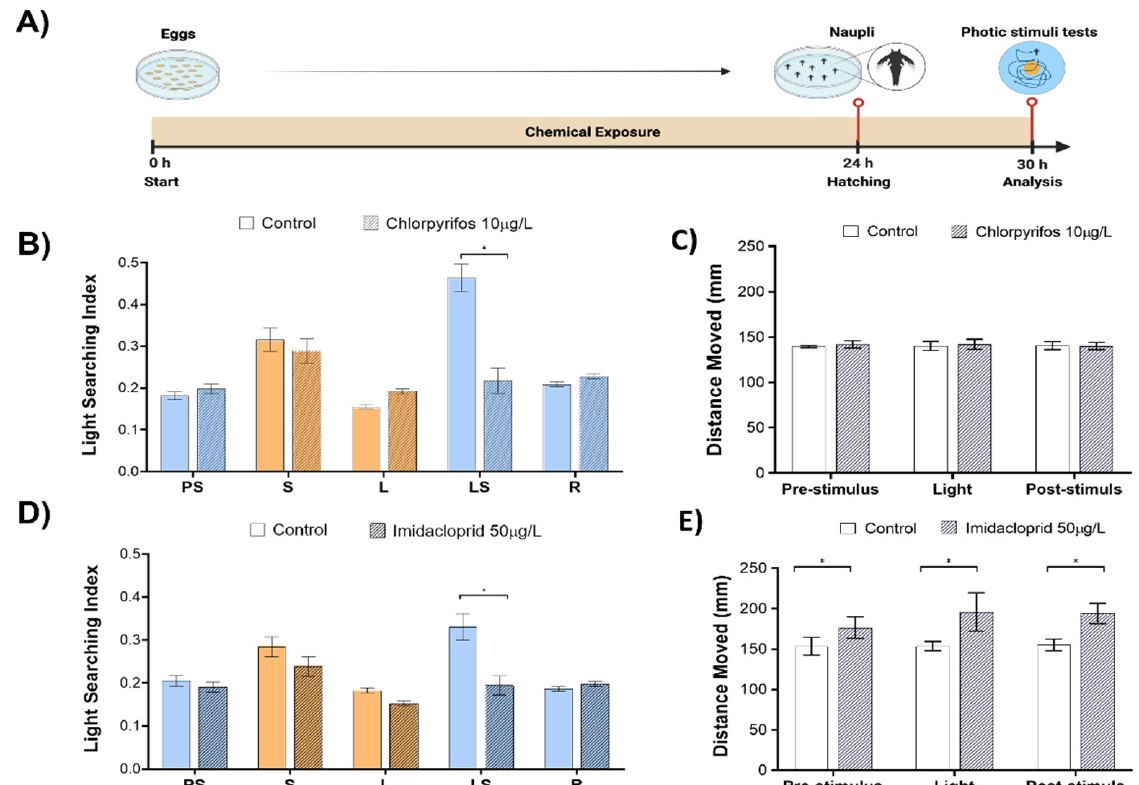
Figure 2. Phototactic responses of larval brine shrimp exposed to sub-lethal concentrations of insecti- cides. ( A ) experiment workflow depicting the phototactic test protocol; ( B ) phototactic fingerprints upon exposure to organophosphate chlorpyrifos (10 µ g/L); ( C ) animal overall motility (total distance moved in mm) analyzed in each phase of light OFF-ON-OFF cycle upon exposure to chlorpyrifos (10 µ g/L); ( D ) phototactic fingerprints upon exposure to neonicotinoid imidacloprid (50 µ g/L); ( E ) animal overall motility (total distance moved in mm) analyzed in each phase of light OFF-ON- OFF cycle upon exposure to imidacloprid (50 µ g/L). At least four independent experiments were performed, averaging data from up to 240 specimens. * p < 0.05 one-way ANOVA. Figure created using www.BioRender.com accessed on 2 August